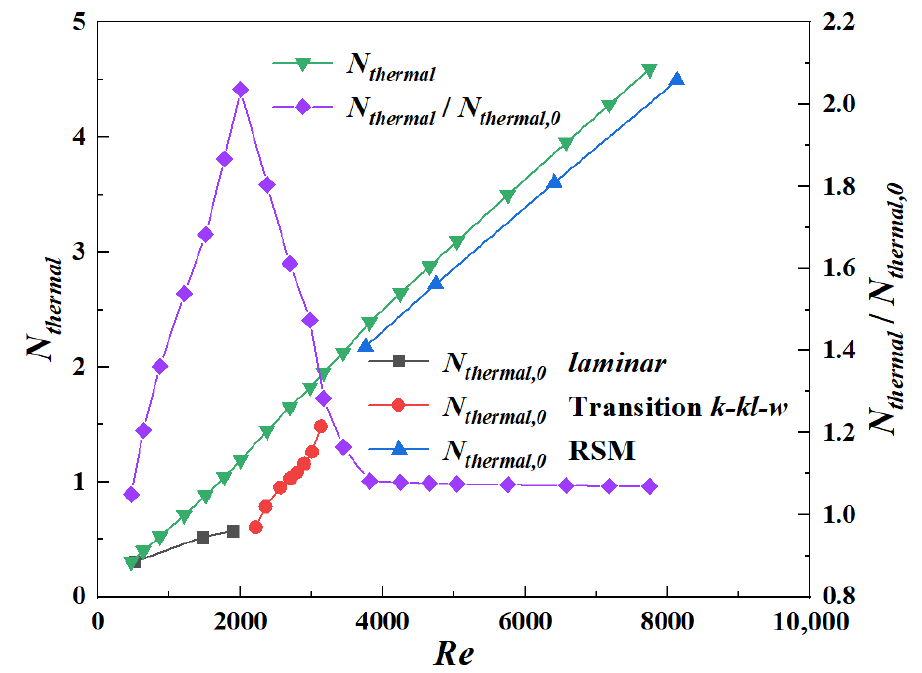
Figure 31. Variation in nondimensional thermal entropy generation rate with Reynolds number.